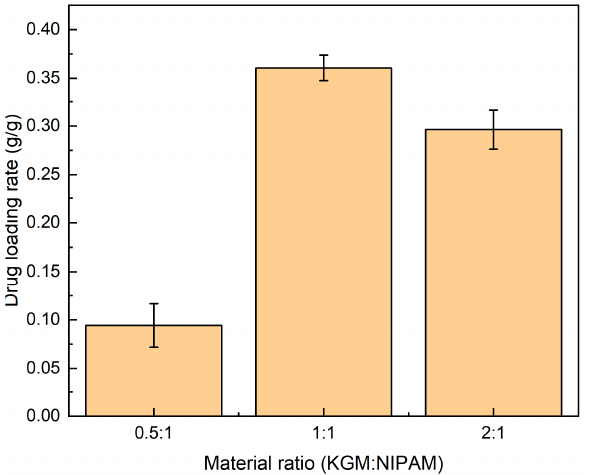
( b ) Figure 4. ( a ) The picture shows the swelling of hydrogels with different ratios under the temperature and pH conditions that simulate the environment in the human body (37 °C, 0–2 h, 0.1 mol/l hydro- chloric acid solution; 3–6 h, pH6.8; 7–10 h, pH7.4); ( b ) The picture shows the swelling of IPN hydro-